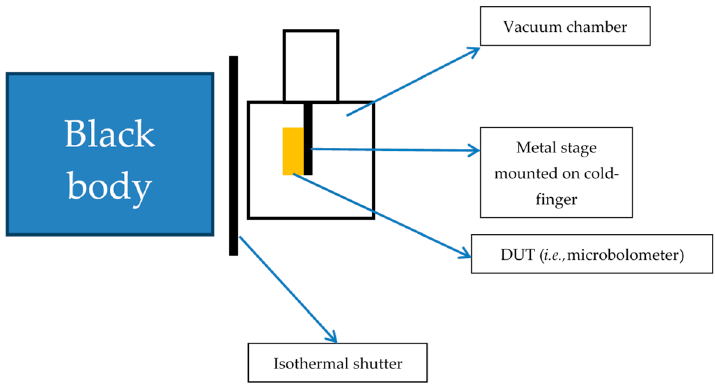
Figure 5. The experimental setup for the thermal radiation on the 4 different microbolometer structures.